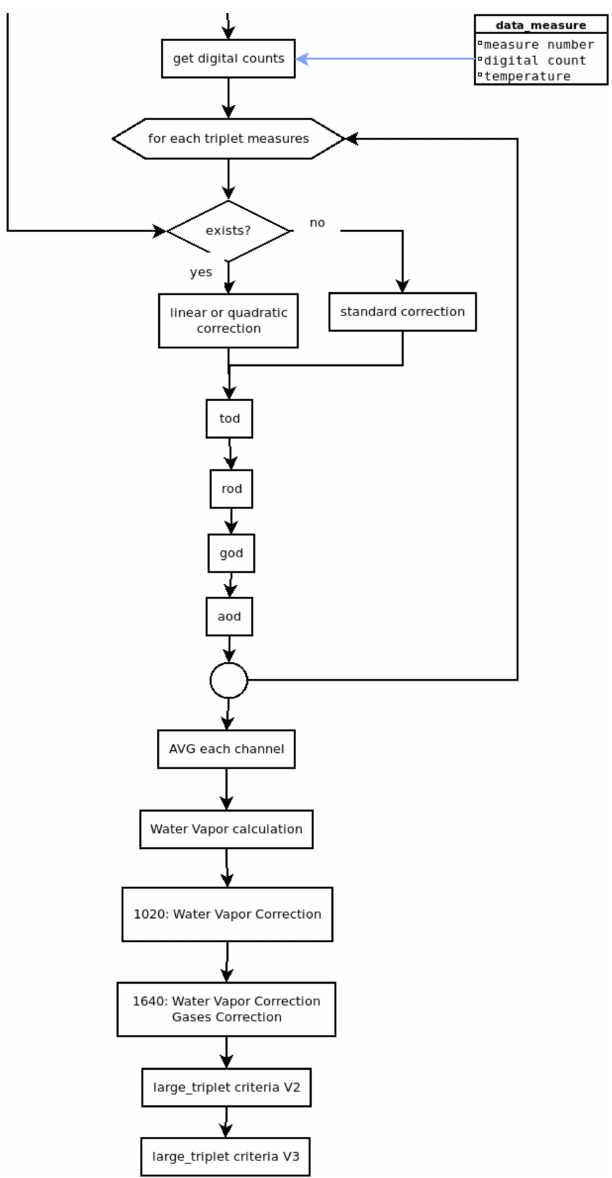
Figure 2. Flux diagram of the AOD computation in